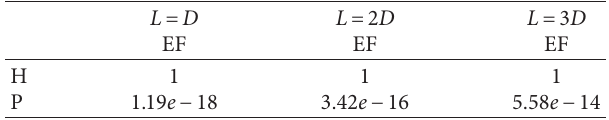
Figure 6: Wall shear stress distribution (E, F each shows wall shear stress at different locations of enlarged vessels with different length of enlarged area varies from L � D to L � 3 D , the maximum wall shear stress value at main wall and sidewall is marked by red circle). (a) Wall shear stress (E). (b) Wall shear stress (F). Table 7: Individual T test results between Groups E and F ( H � 1 suggests the close interrelationship within wall shear stress fluc- tuating